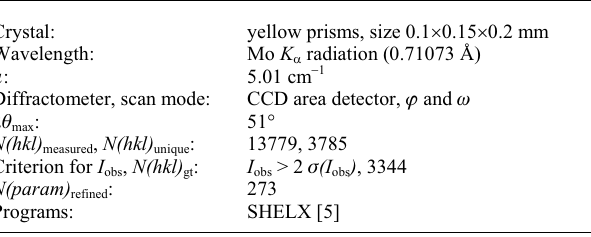
Table 2. Atomic coordinates and displacement parameters (in Å 2 )